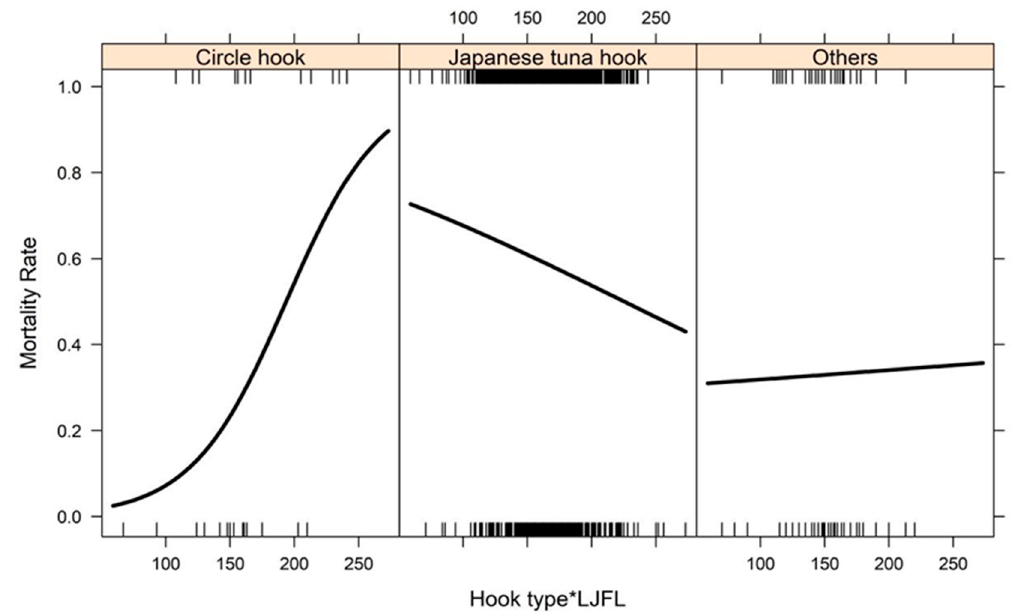
Figure 5. The effect of the interaction term between hook type and lower jaw fork length (LJFL) on the at-haulback mortality of Indian Ocean swordfish. The different boxes indicate the variation of the at-haulback mortality of the Indian Ocean swordfish with the LJFL when the hook type (circle hook, Japanese tuna hook, others) is used. The short lines at the top and bottom of the picture respectively indicate the number of samples that died and survived under the LJFL.